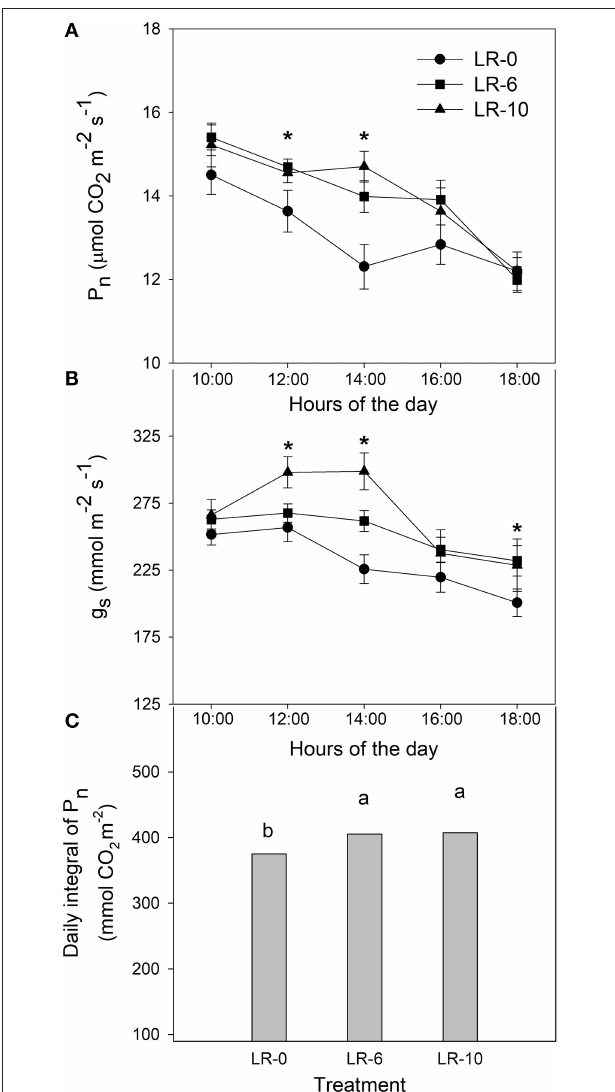
FIGURE 4 | Effects of early leaf removal on daily leaf net CO 2 assimilation rate (A) , stomatal conductance (B) and daily integral of P n three weeks after full bloom (C) . Means were based on 3 replicates. Error bars represent standard error of the mean (SE). Symbol (*) represent significant difference at P < 0.05. Different letters indicate significant effects of the treatment at P < 0.05 by Tukey’s HSD test. LR-0, no leaves removed; LR-6, leaves removed from 6 basal nodes; LR-10, leaves removed from 10 basal nodes at bloom.